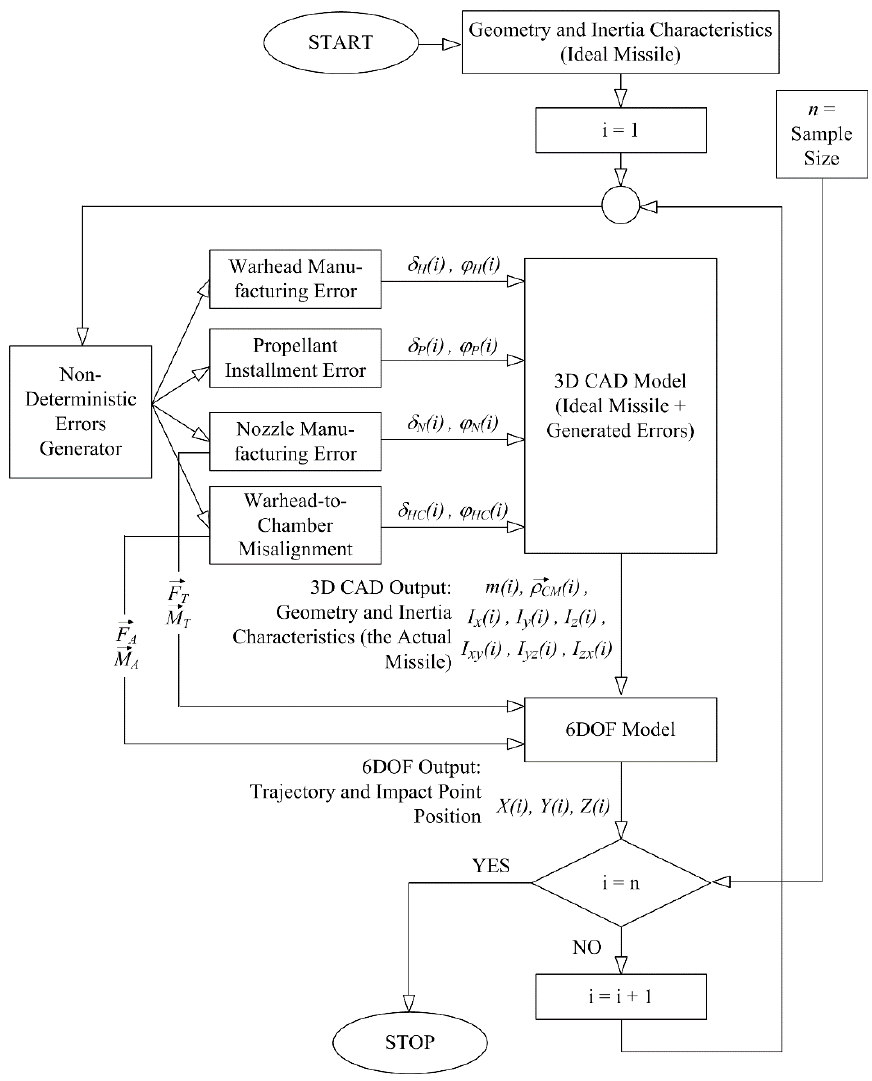
Figure 5. Monte-Carlo Simulation scheme [16].